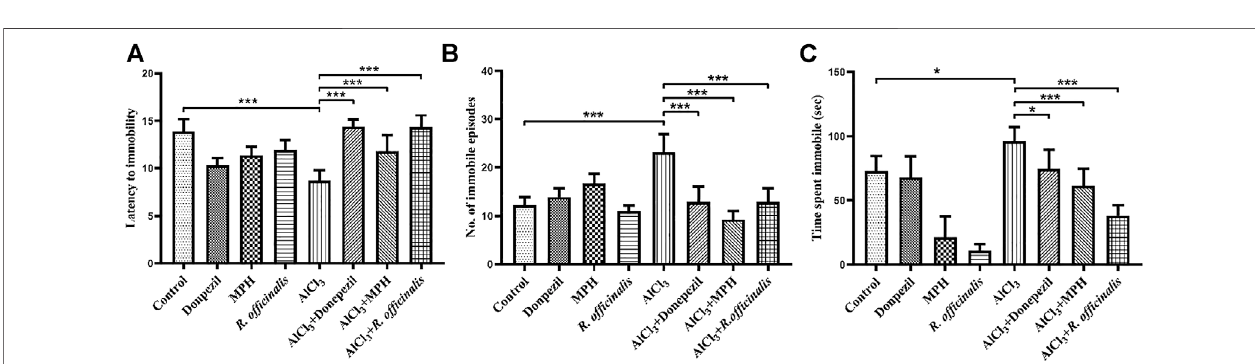
FIGURE3 | Effects ofDonepezil,MPH, and R. of fi cinalis on depression-like behavior inthe forced swim test. (A) Graph depicting latency to immobility, (B) number of immobile episodes, and (C) time spent immobile. One-way ANOVA followed by the Bonferroni comparison test (mean ± SEM) was applied to analyze the data using GraphPad Prism. n = 8. *** p < 0.001, * p < 0.05, ns nonsigni fi cant.